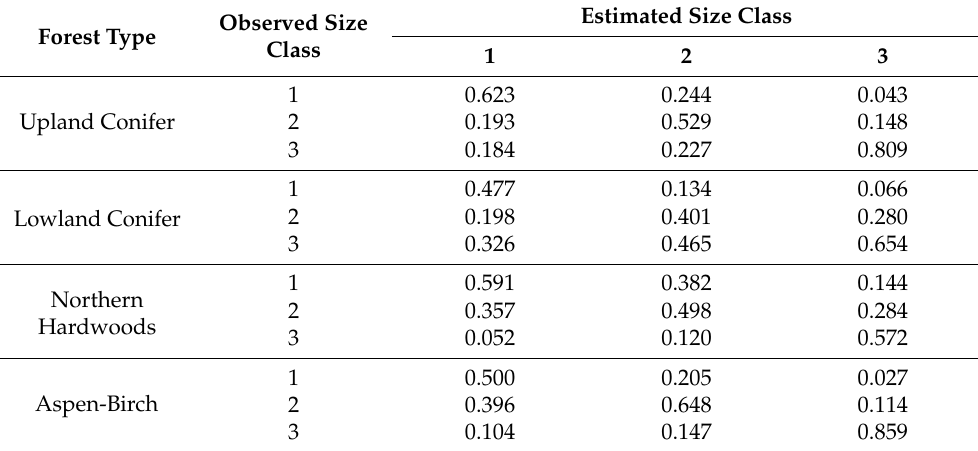
Table 4. Ratio adjustments for each forest type/estimated size class combination. Values in the table are reported as proportions of the estimated total number of plots in a size class (i.e., condi- tional proportions based on columns). Each proportion represents how plots or hectares within an estimated size class should either remain in the estimated size class (diagonal elements within each forest type group) or be redistributed to the other classes based on known classification er- ror rates (off-diagonal elements). Size classes were coded as 1—sawtimber, 2—poletimber, and 3—seedling/sapling. Data came from FIA plot records spanning